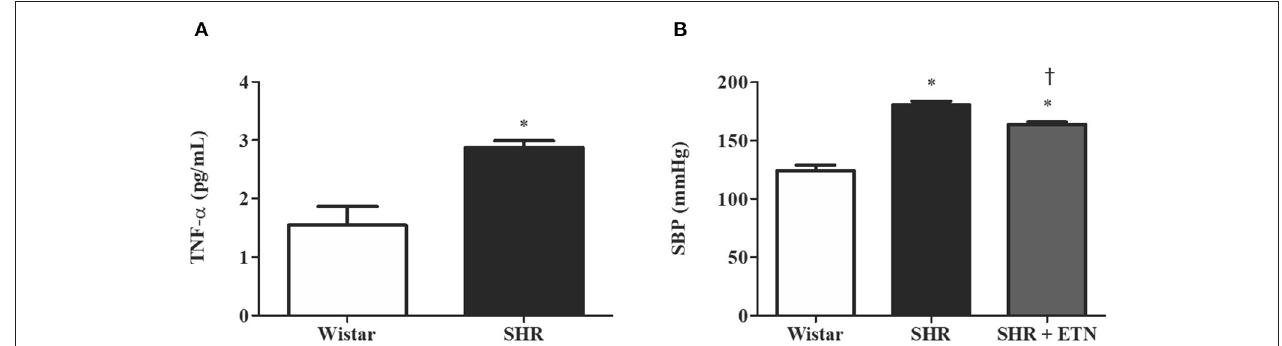
FIGURE 1 | Placental tumor necrosis factor-alpha (TNF- α ) levels and systolic blood pressure (SBP) are greater in spontaneously hypertensive rats (SHRs) compared to Wistar rats, and etanercept treatment reduces, without normalizing, SBP in treated SHRs. (A) Bar graph showing placental TNF- α levels (pg/ml) in SHR and Wistar; n = 6. (B) Bar graph showing SBP (mmHg) in SHR, Wistar, and SHR treated with etanercept; n = 5. Values are presented as means ± SEM, and data were analyzed by (A) Student’s t -test or (B) one-way ANOVA, followed by Tukey posttest. * p < 0.05 vs. Wistar; † p < 0.05 vs. SHR.